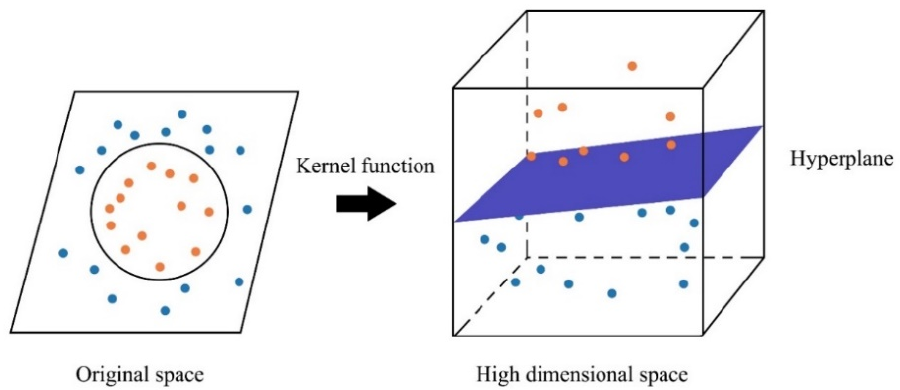
Figure 6. The principle analysis of the kernel function in the SVM linear inseparable problem.